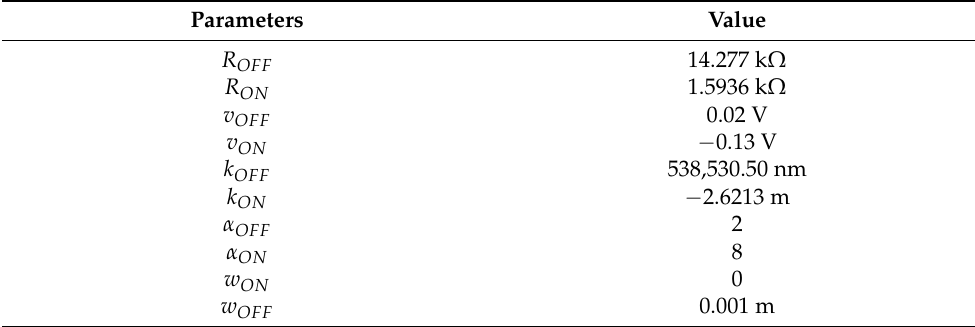
Table 1. Model parameters obtained by the simulation of the optimization algorithm.